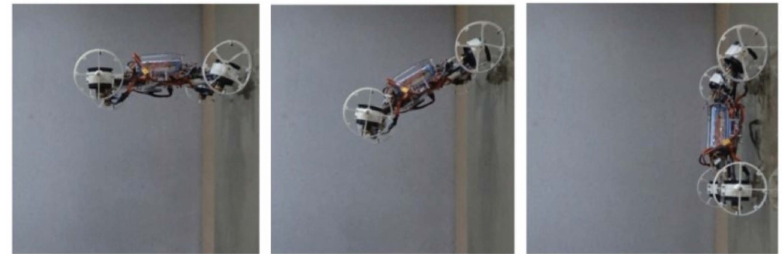
Figure 39. Wall-climbing robot with drone platform [134].